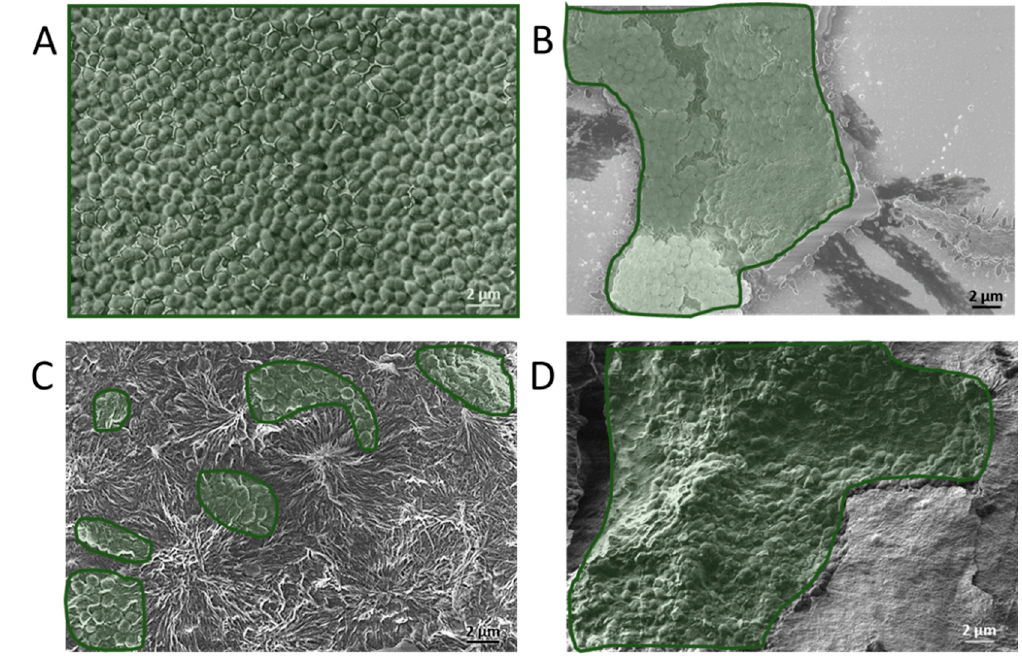
Figure 4. Biofilm analysis by HRSEM. ( A ) E. faecalis and ( B ) S. mutans form biofilm on the non-coated surface, ( C ) E. faecalis and ( D ) S. mutans incubated on Fmoc-F 5 -Phe-coated surface. The areas covered with bacteria are marked in green.